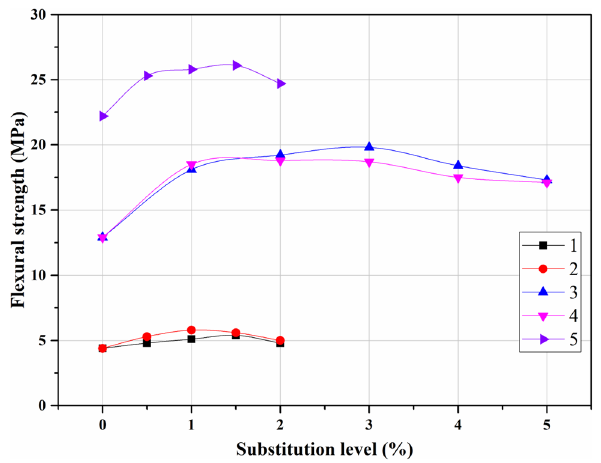
Fig. 7 Variation of 28-day flexural strength of concrete with substi- tution level of nanoparticles: (1) 80 nm nano-SiO2 [12]; (2): 15 mm nano-SiO [12]; (3): nano-SiO [13]; (4): nano-Ferrite [13]; (5): nano- 2 2 CaCO